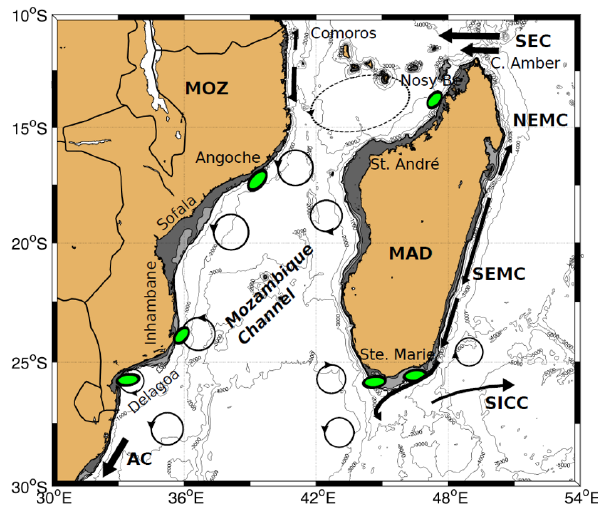
Figure 9. Bathymetry and major circulatory features in the Mozam- bique Channel and around Madagascar. Currents include the South Equatorial Current (SEC), Northeast Madagascar Current and Southeast Madagascar Current (NEMC and SEMC), South Indian Countercurrent (SICC), and the Agulhas Current (AC). Shaded ar- eas show the extent of the continental shelf to a depth of 200m. Green ellipses denote upwelling areas.